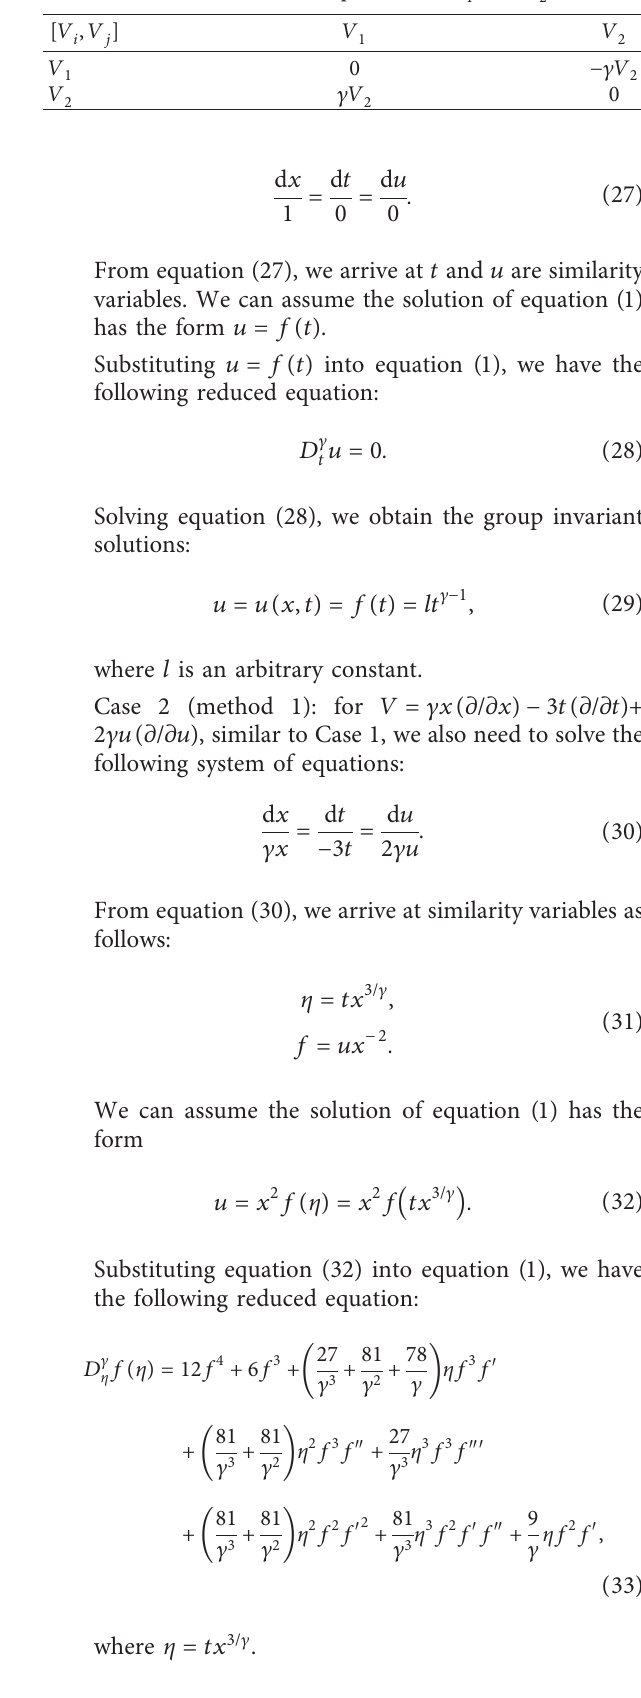
Table 1: Lie bracket operation of V